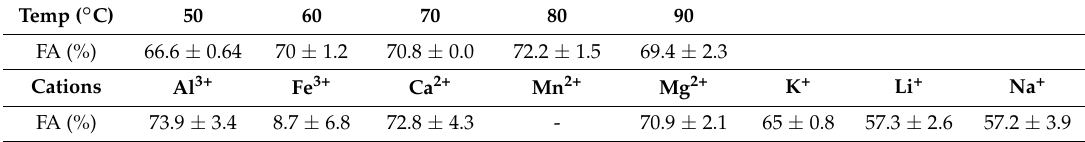
Table 2. Effect of Temperature and Cation on the Flocculating Activity of Purified